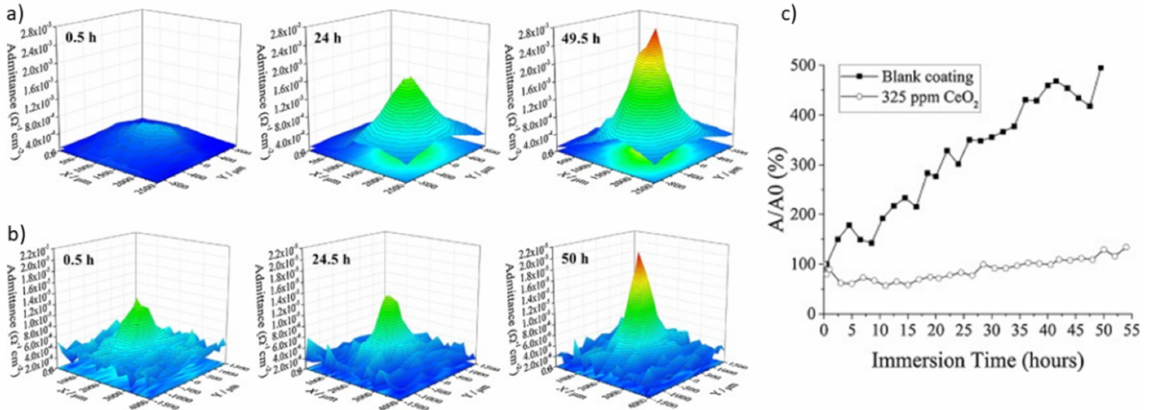
Figure 9. LEIS admittance mapping over an artificial defect on the surface of ( a ) blank and ( b ) CeO 2 - modified coating after 0.5 h, 24.5 h, and 50 h immersion in 0.005 M NaCl; ( c ) Ratio between the measured admittances during LEIS and the first registered admittance for each sample. Reproduced with permission of Elsevier